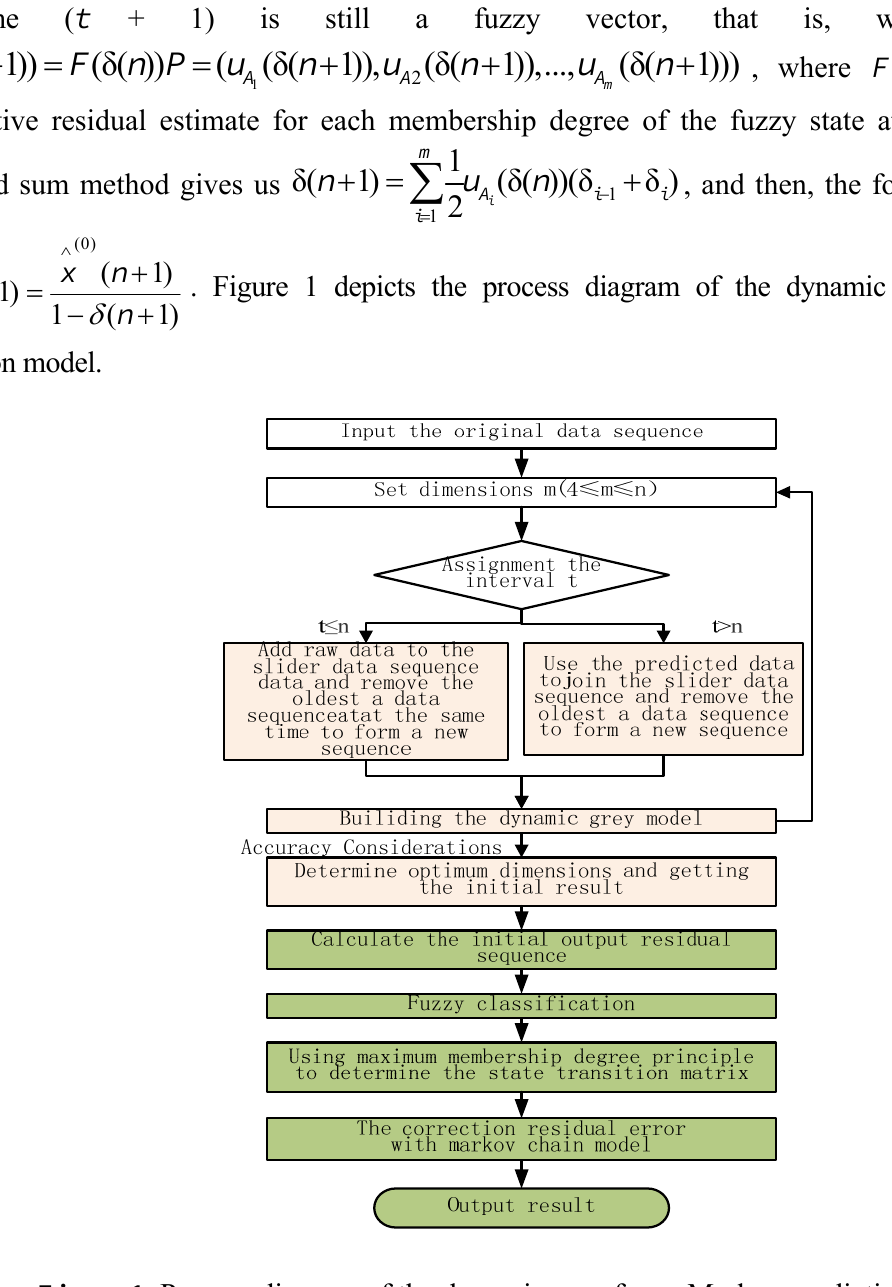
Figure 1. Process diagram of the dynamic grey fuzzy Markov prediction